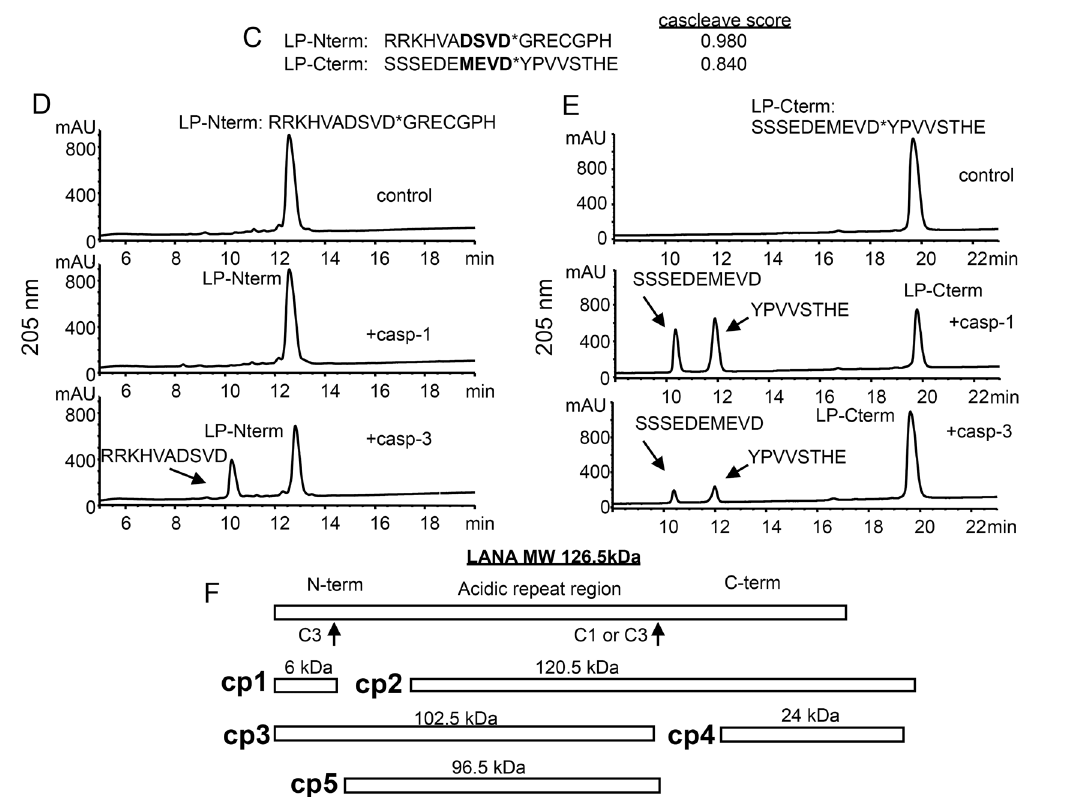
Fig 1. Changes in KSHV LANA following treatment of BCBL-1 cells with varying concentrations of H 2 O 2 and sequence analysis of LANA identifying potential caspase cleavage sites. (A) BCBL-1 cells were cultured in media at 500,000 cells per ml to which was added H 2 O 2 at 100 and 200 μ M (diluted into PBS) or PBS as a control for 20 hrs. Nuclear and cytoplasmic extracts (10 μ gs per sample) were prepared and analyzed by western blot for LANA using a monoclonal antibody that is directed towards the C-terminal region of LANA (Leica), and with antibodies directed toward TBP (rabbit) and HSP90 (mouse). Blots were then incubated with appropriate secondary antibodies (goat anti-mouse or rabbit IR800 secondary antibody) and analyzed using the LiCor system. Full length LANA (LANA-fl) and three faster migrating forms of LANA (arrows) are indicated. Molecular weight markers in kDa are indicated to the left of the blot. Full length LANA (calculated molecular weight of 126 kDa based on the amino acid sequence) migrates at approximately 165 kDa in the Nupage LDS gel system. HSP90 is shown as a cytoplasmic loading control and TBP as a nuclear loading control. (B) The 1095 LANA amino acid sequence